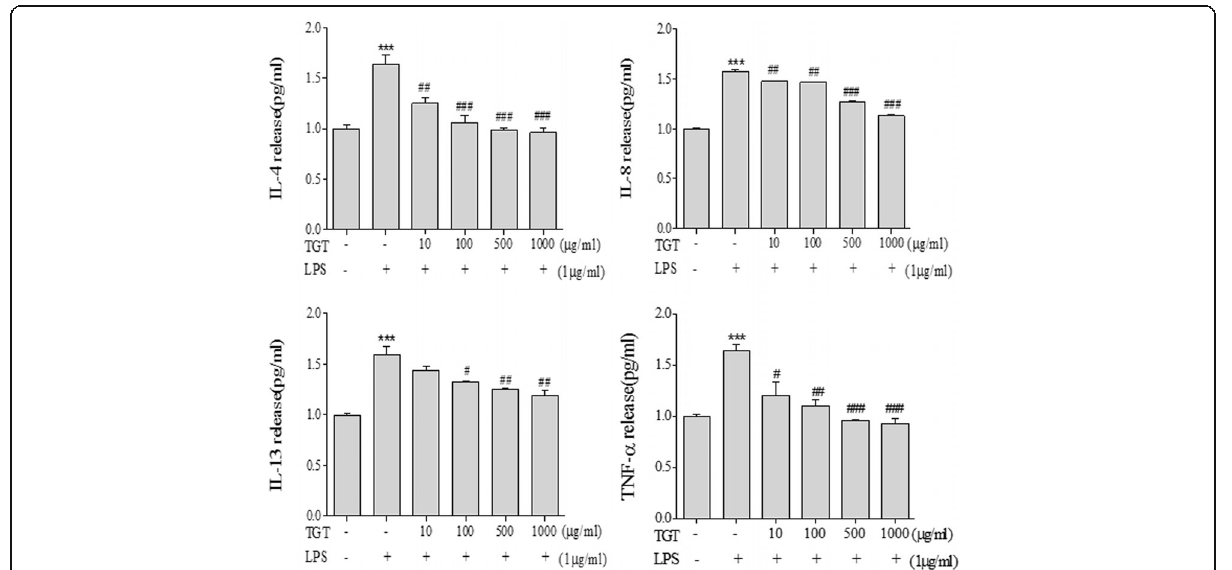
Fig. 5 Effect of TGT on the release of pro-inflammatory cytokines in HaCaT cells. LPS-stimulated HaCaT cells were treated with or without different doses of TGT for 24 h. The levels of secreted pro-inflammatory cytokines in the cell culture supernatant were measured by ELISA. *; compared to control. #; compared to stimulated cells. Control; HaCaT with LPS ( − ), Stimulation; HaCaT with LPS